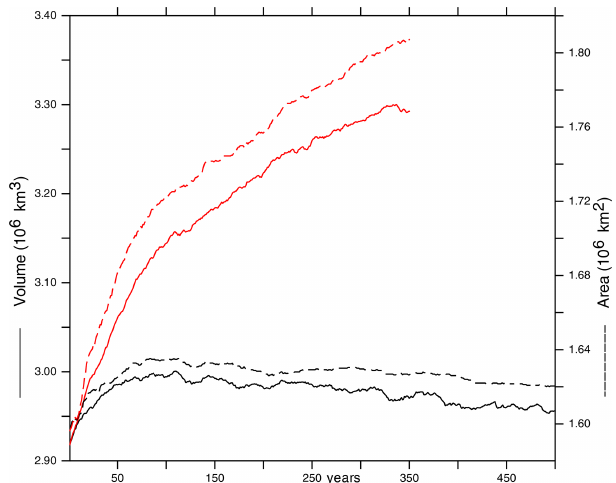
Figure 9. Spin-up of the Greenland ice sheet in the coupled FAMOUS-ice. Ice sheet volume ( × 10 6 km 3 LWE, solid lines, left axis) and area ( × 10 6 km 2 , dashed lines, right axis) are shown. Black: calving imposed near the observed ice edge; red: ice sheet allowed to calve at the coast. Asynchronous coupling was used: the time axis shows climate model years; the ice sheet evolves 10 years for every 1 year of